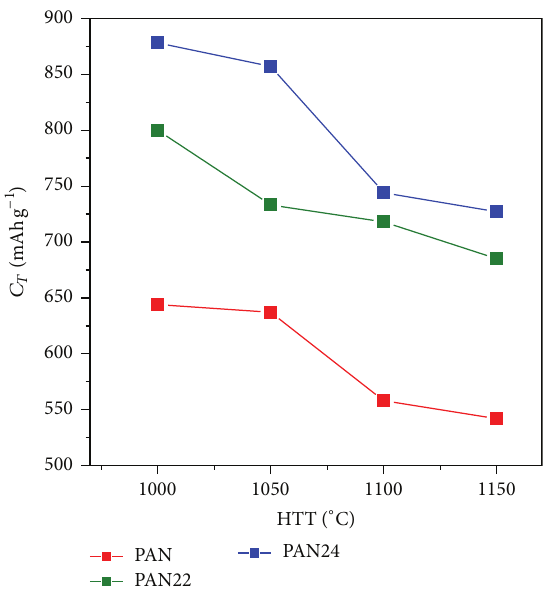
Figure 7: Variation of the first discharge lithium insertion capacity with HTT of pristine and oxidized polyacrylonitrile.